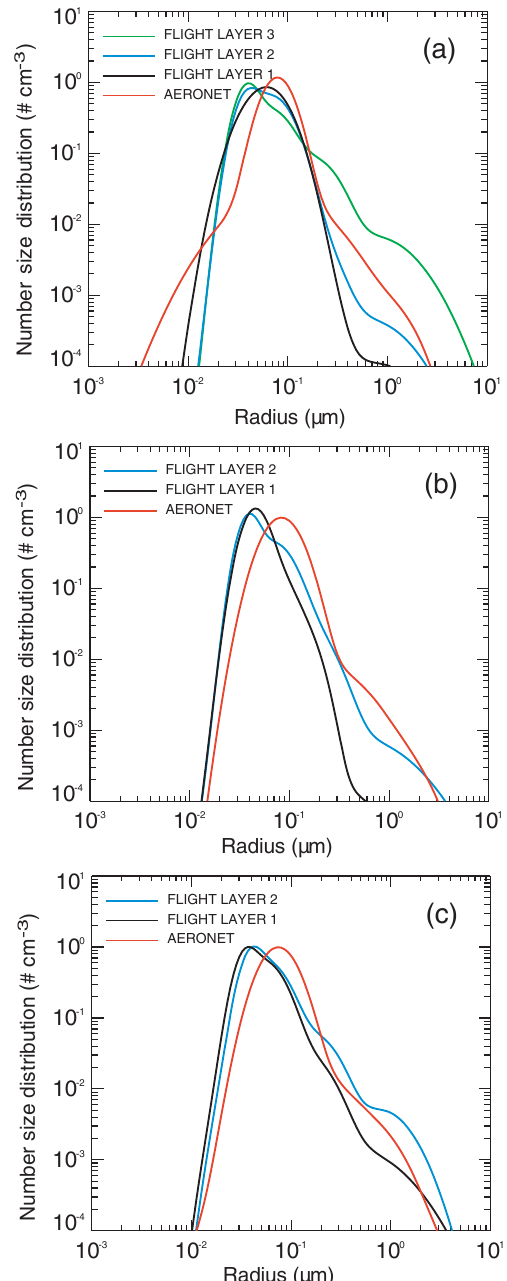
Figure 4. Normalized aerosol number size distribution derived from AERONET measurements (red curve) and from the airborne in situ measurements for the layers of Fig. 3 for (a) F35, (b) F38, and (c)